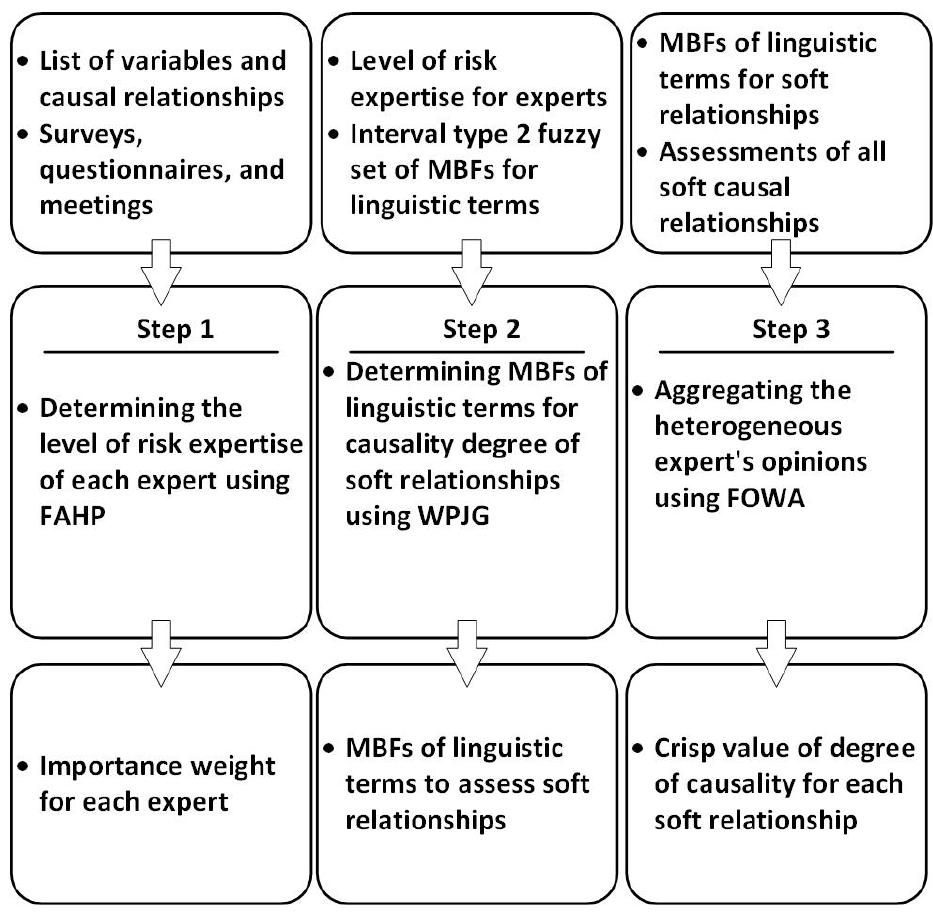
Figure 2. Inputs and outputs of all steps in adaptive hybrid model to determine soft causal relation- ships in fuzzy system dynamics (FSD) modeling.